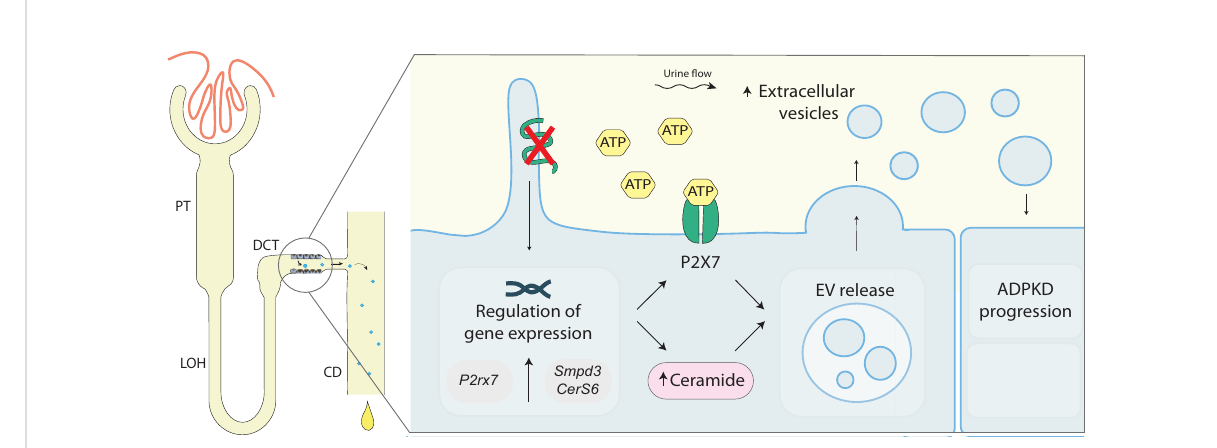
FIGURE 6 Proposed role of polycystin-1 de fi ciency in EV release in the distal convoluted tubule. Loss of Pkd1 -/- in mDCT15 cells is associated with an increase in the EV release and an increase in the expression of P2xr7 , S mpd3 and CerS6 , genes encoding for proteins involved in ATP signaling and ceramide synthesis, respectively. These fi ndings suggest a link between the loss of Pkd1 expression, ceramide biosynthesis and EV release. The latter can stimulate cysts development in the surrounding tissue contributing to ADPKD disease progression. ADPKD, Autosomal dominant polycystic kidney disease; CD, collecting duct; CerS6 , Ceramide Synthase 6; DCT, distal convoluted tubule; EV, extracellular vesicles; LOH, Loop of Henle; PC1, polycystin 1; PT, proximal tubule; P2rx7 , Purinergic Receptor P2X 7 (gene); P2X7, Purinergic Receptor P2X 7 (protein); Smpd3 , Sphingomyelin Phosphodiesterase